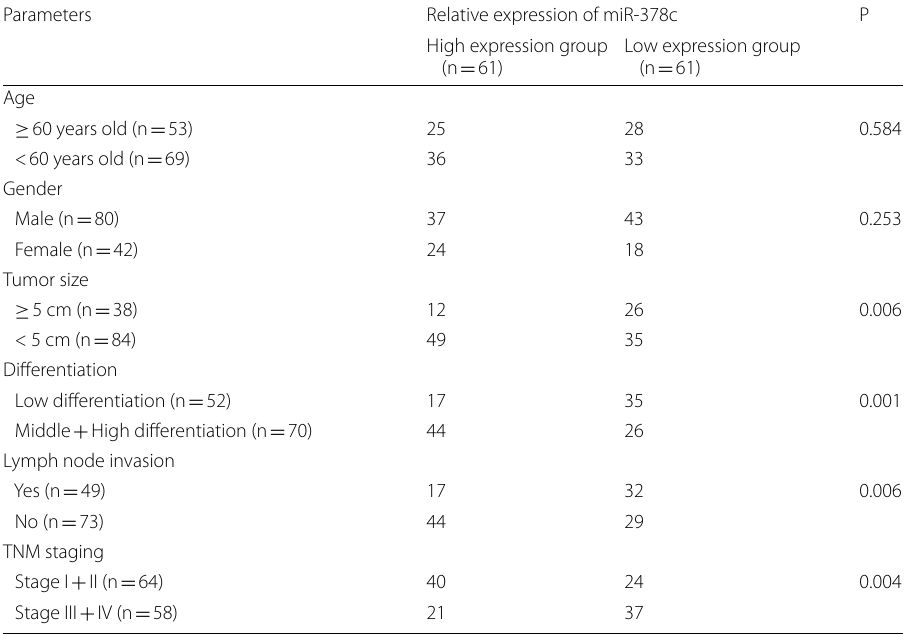
Table 1 Relationship between miR-378c and pathological data of patients with gastric cancer Parameters Relative expression of